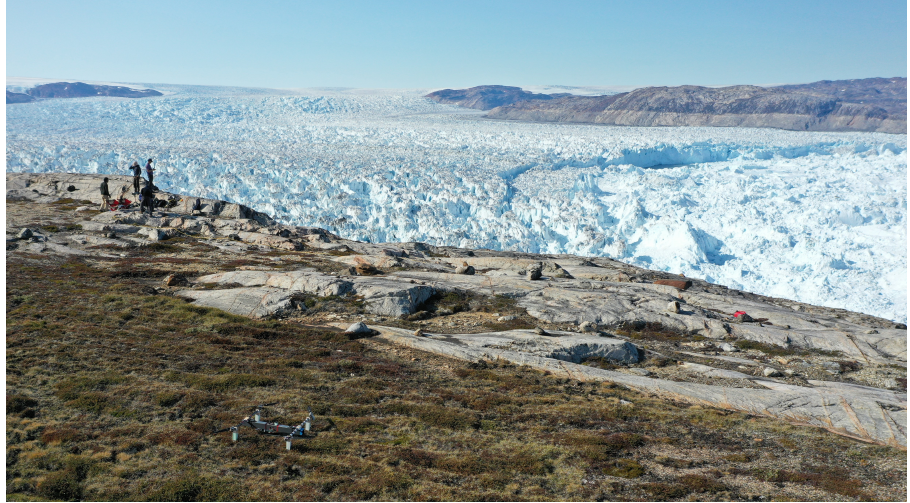
Figure 8. Base camp at the Helheim Glacier with the data-collection drone in the